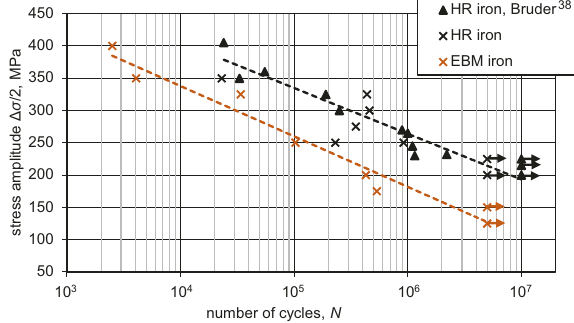
Fig. 4 S - N curves for both material states. Fatigue life in rotating bending for HR iron (with data from refs. 18,38 ) and EBM